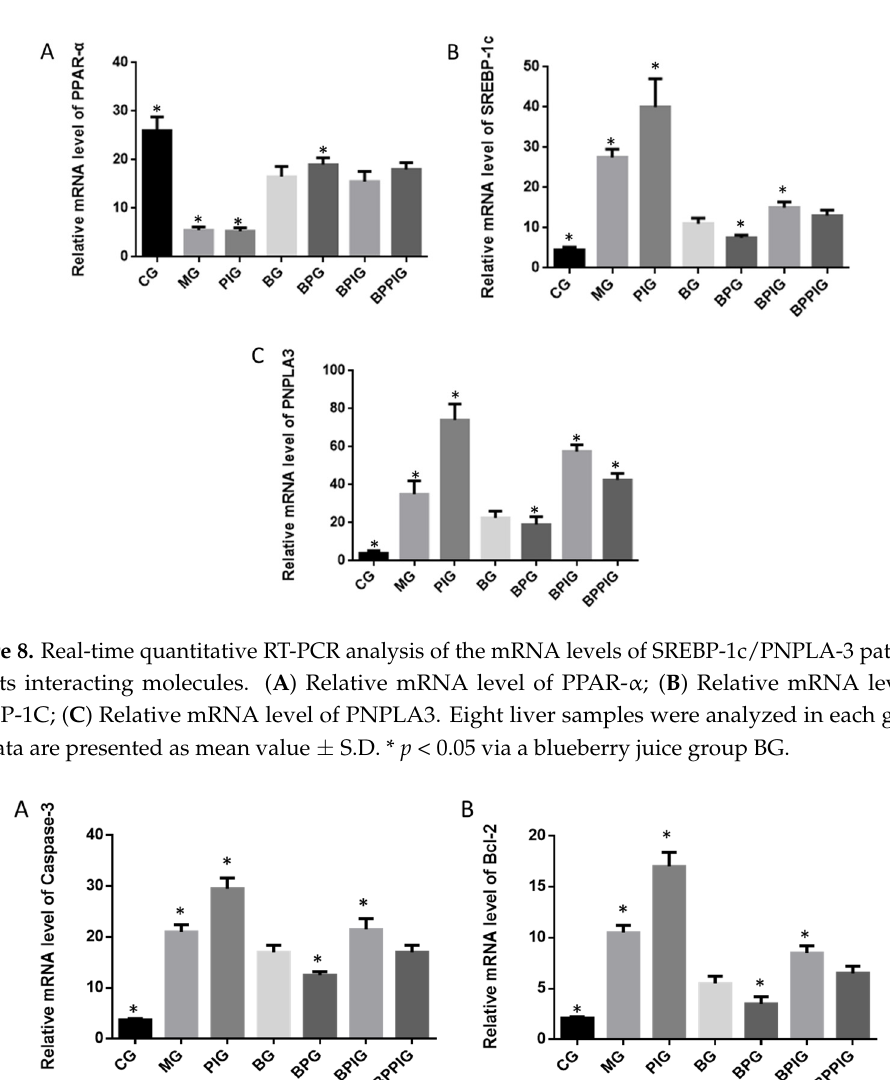
Figure 9 . Real ‐ time quantitative RT ‐ PCR analysis of the mRNA levels of apoptotic factors: ( A ) relative mRNA levels of caspase ‐ 3; and ( B ) relative mRNA levels of Bcl ‐ 2. Five liver samples were analyzed in each group. All data are presented as mean value ± S.D. * p < 0.05 via a blueberry juice group BG.